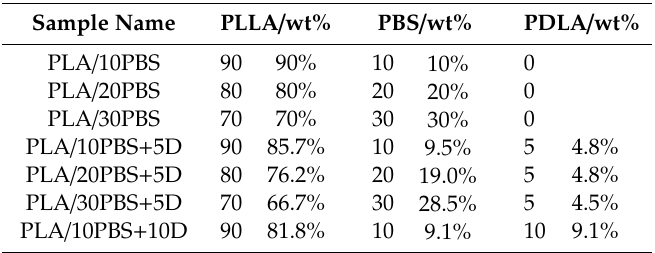
Table 1. Composition of PLA / poly (butylene succinate) (PBS)-based blends with or without poly ( d -lactide)